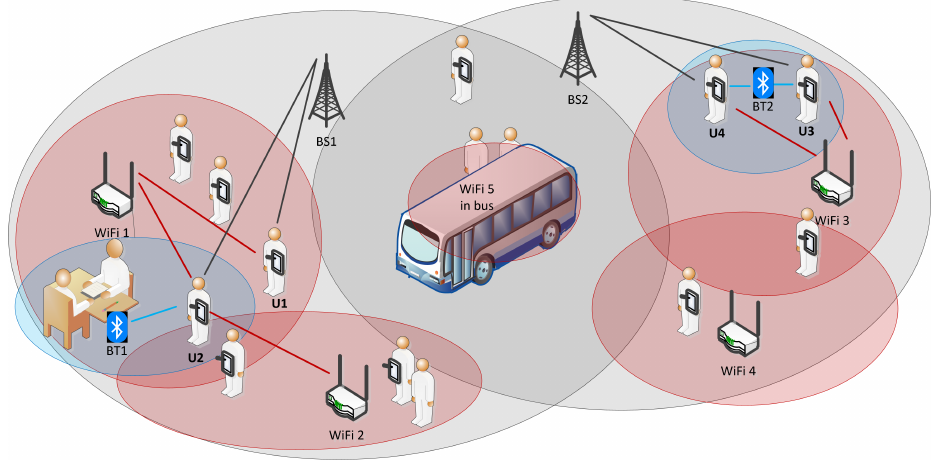
Figure 1. Concept of radio-environment based proximity